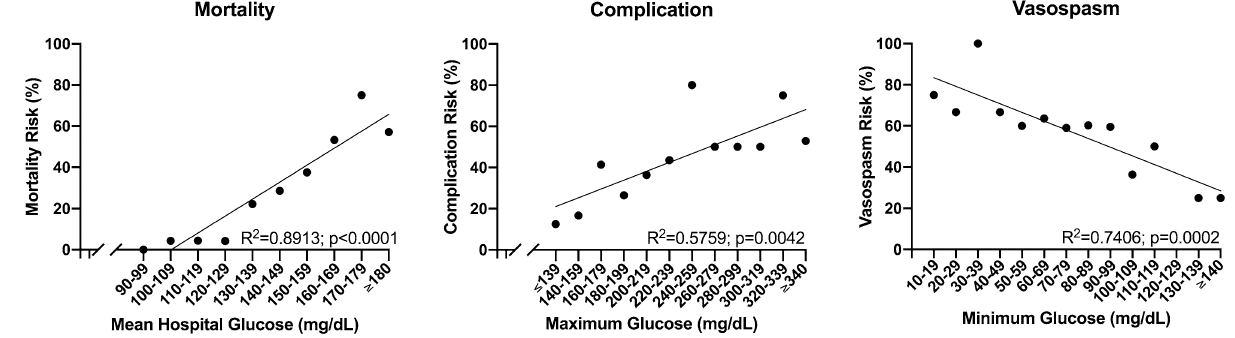
Figure 2. Risk of mortality (left), complications (middle), and vasospasm (right) versus glycemic variables that were significant in multivariate analysis. Each glycemic variable was binned into ordinal groups, and only groups with ≥ 2 members are shown. Simple linear regressions are shown.